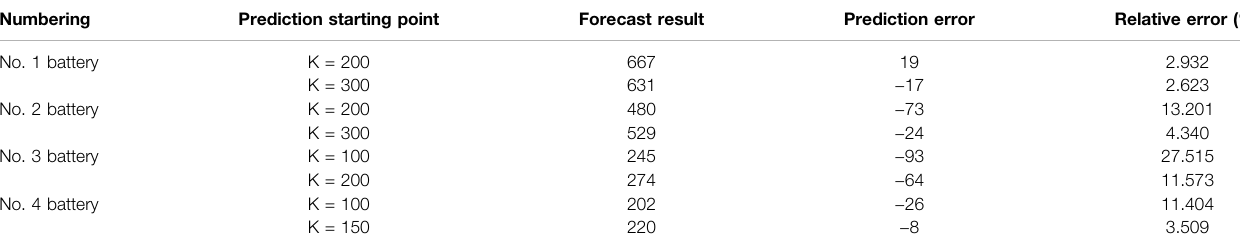
TABLE 2 | Prediction results of the particle fi lter algorithm for batteries 1 – 4.